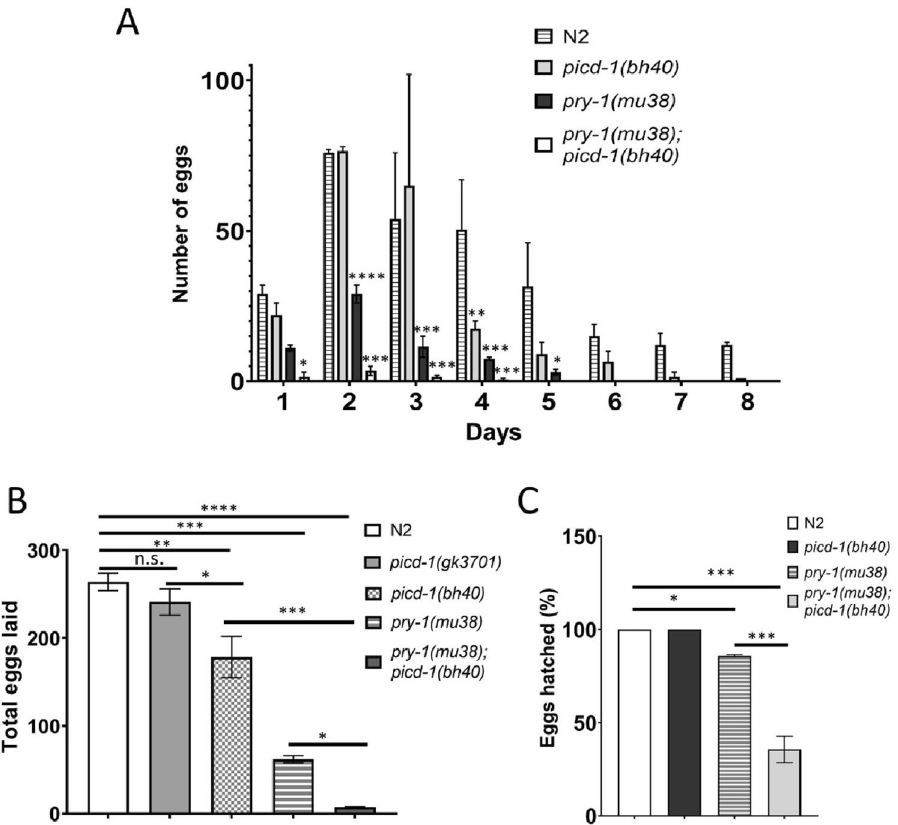
Figure 6. picd-1 regulates brood size and embryonic viability. Bar graphs showing eggs laid on each day ( A ) , totals number of eggs ( B ), and percentage of the hatched eggs ( C ) by N2 and single and double mutant animals. Data represent a cumulative of two replicates (total n = 10 for each genotype shown in panels ( A ) and ( B ); and n = 500 for N2, 120 for pry-1(mu38) and 14 for pry-1(mu38); picd-1(bh40) double mutants shown in panel ( C ) and error bars represent the standard deviation. ( A ) Statistical analyses were done using two-way ANOVA with Tukey’s multiple comparison test and recorded in Table S2. ( B,C ) Statistical analyses were done using one- way ANOVA with Dunnett’s multiple comparison test and significant differences are indicated by stars (*): * ( p < 0.05), ** ( p < 0.01), *** ( p < 0.001), and **** (p < 0.0001). n.s., not